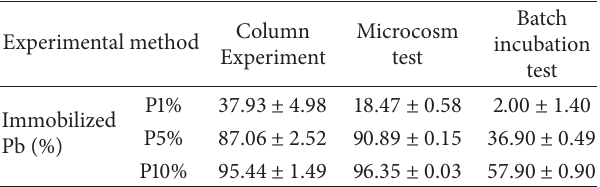
Table 1: Comparison of immobilized Pb according to the experi- mental method (control: Pb-contaminated soil without peat moss, P1%: Pb-contaminated soil with 1% peat moss, P5%: Pb-contam- inated soil with 5% peat moss, and P10%: Pb-contaminated soil with 10% peat